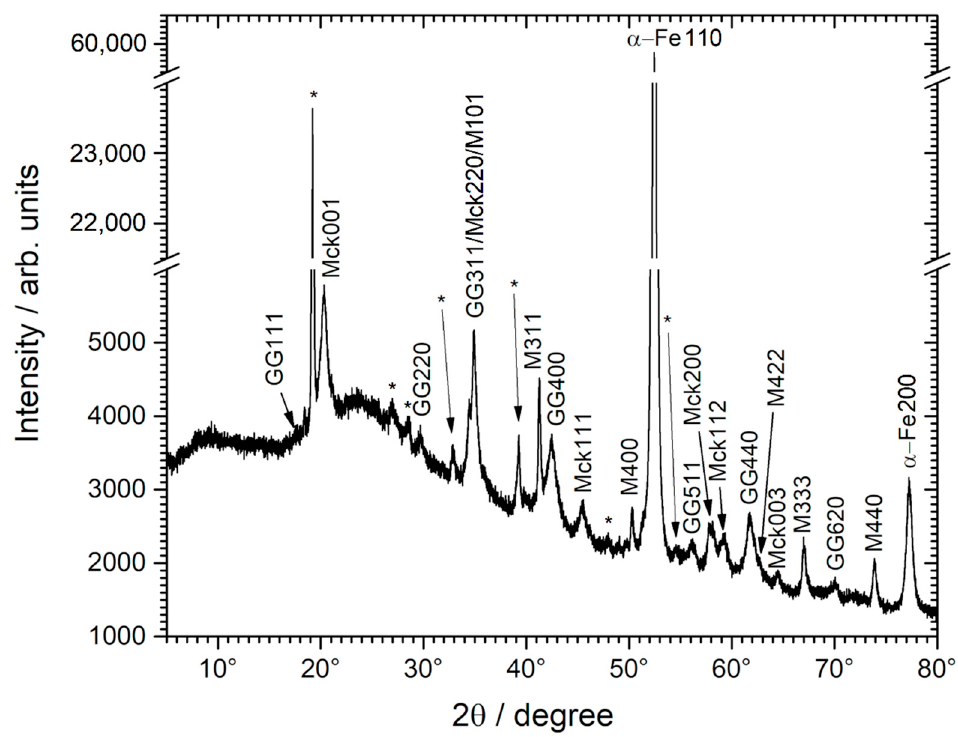
Figure 4. XRD analysis of the corrosion product layer covering a carbon steel sample after the experiment. GG, Mck, M and, α -Fehkl are the diffraction peaks of greigite, mackinawite, magnetite, and α -Fe with the corresponding Miller index. The * points out the diffraction peaks of an unidentified corrosion product.